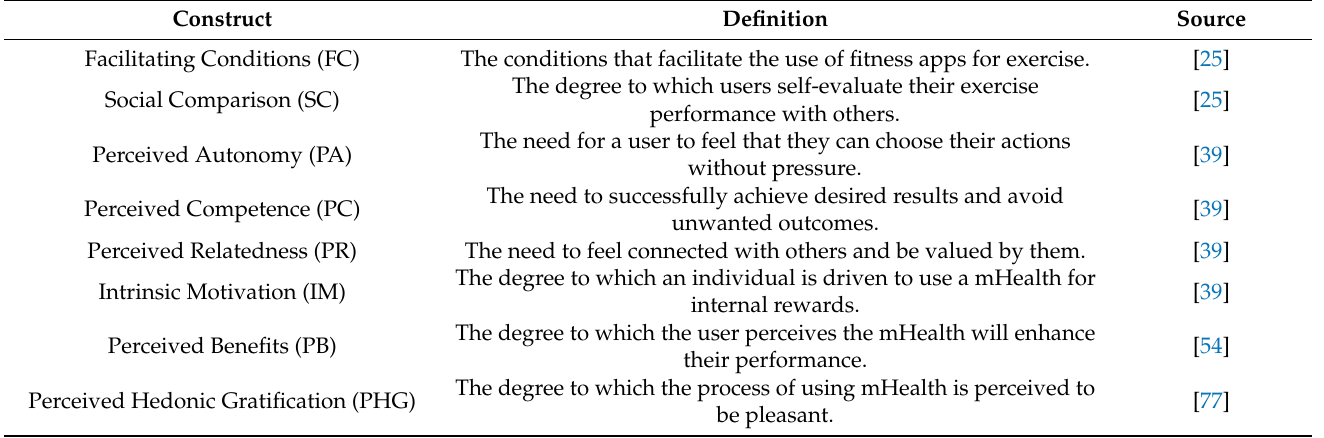
Table 1. Sources of